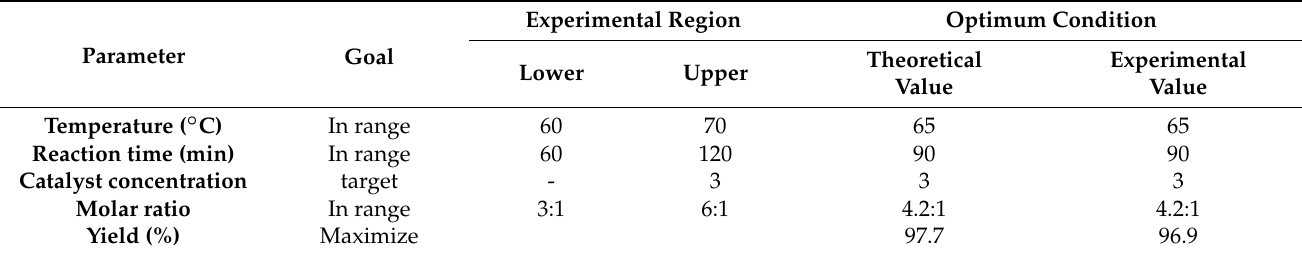
Table 5. Numerical optimization results and constraints for the factors/response.